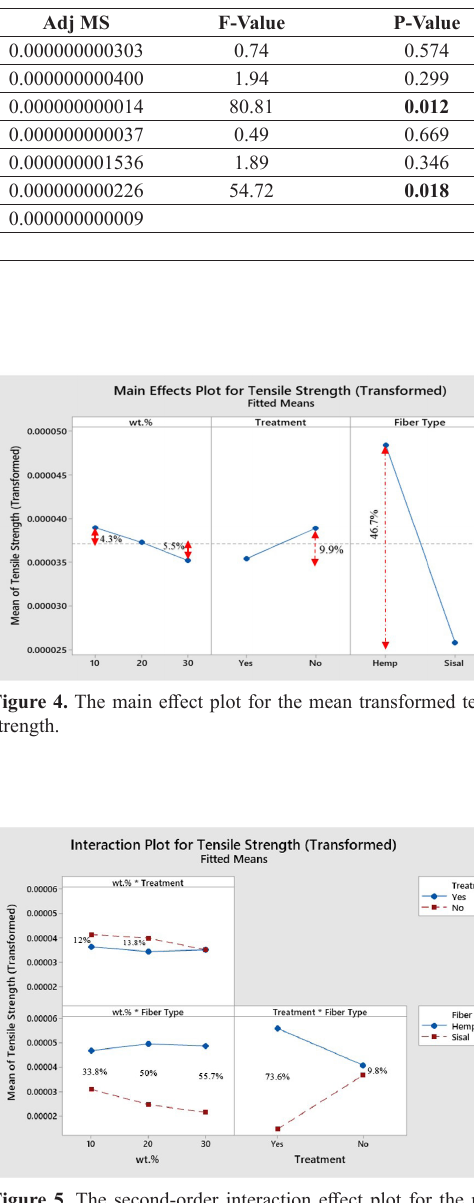
Table 5. Analysis of Variance (ANOVA) for transformed tensile strength.